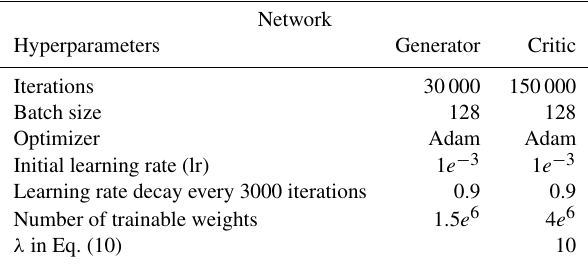
Table 1. Hyperparameters for training